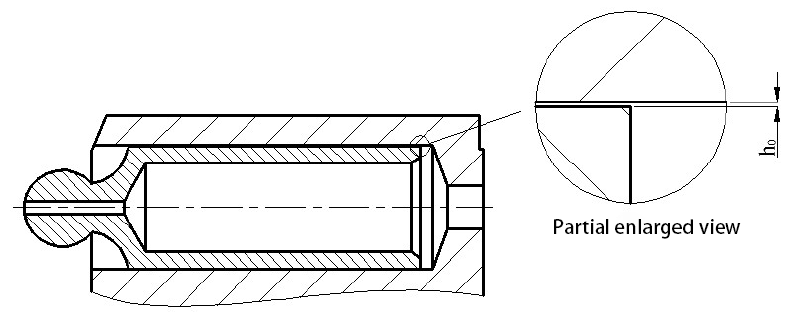
Figure 4. The piston and cylinder bore.